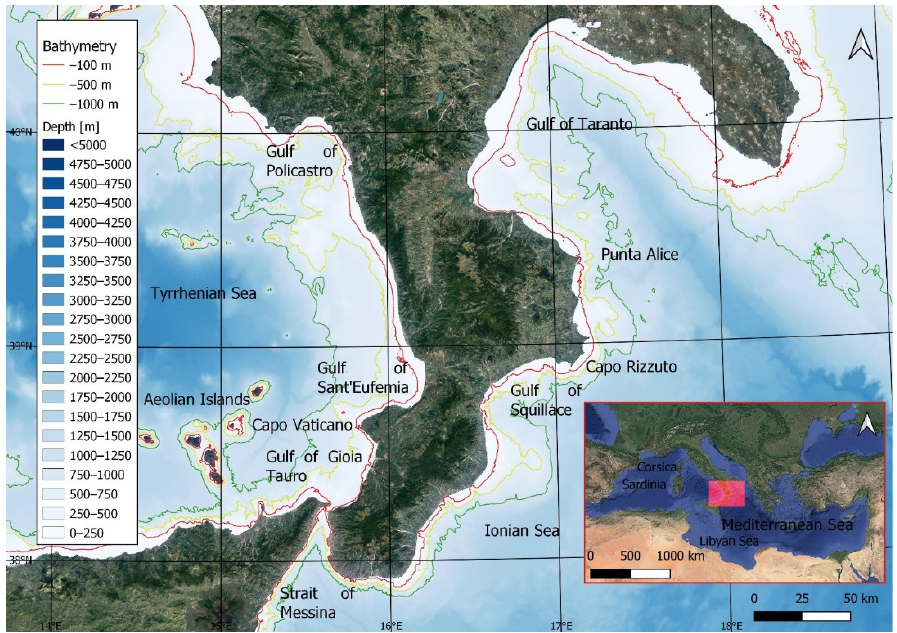
Figure 1. Calabria region (large panel). Geographical position of Calabria region in the center of Mediterranean Sea (small panel).